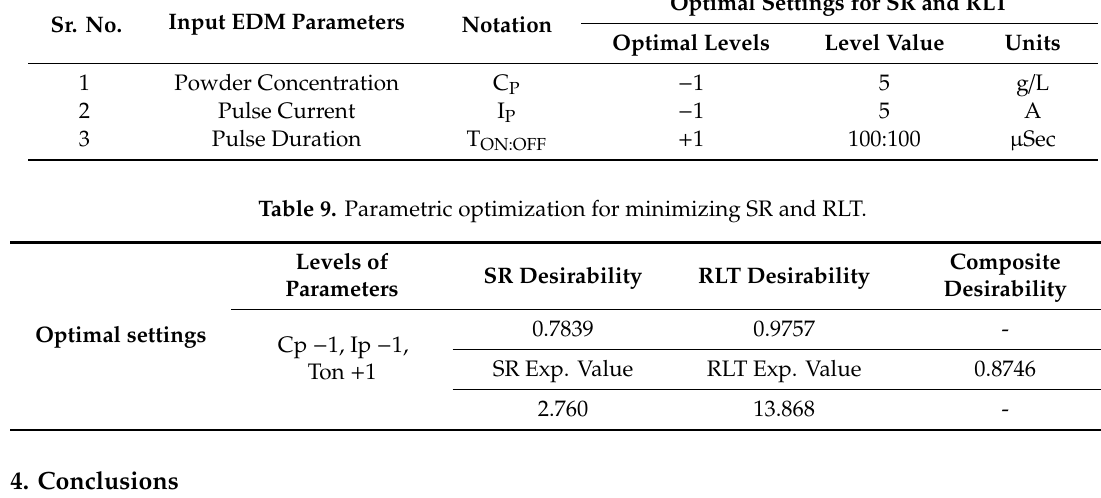
Table 9. Parametric optimization for minimizing SR and RLT.